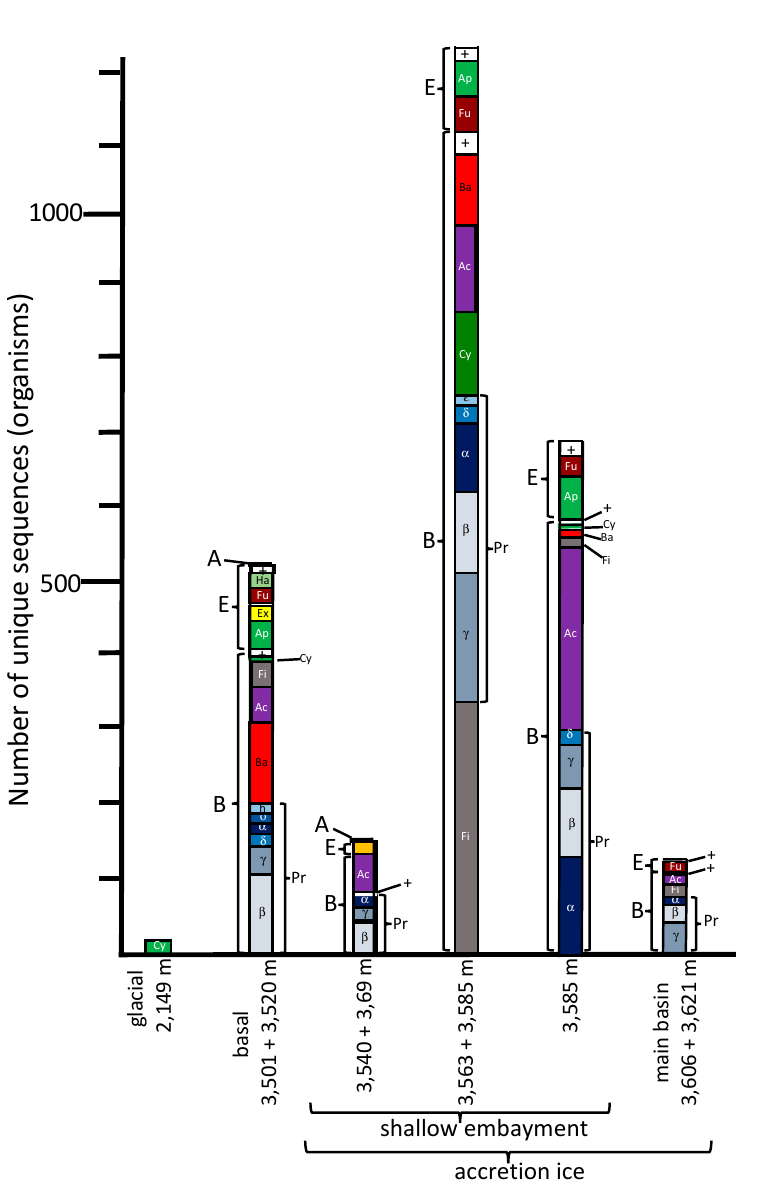
Figure 2. Comparisons of the total numbers and taxonomic affinities of sequences from each of the ice core samples. Abbreviations: Domains—A = Archaea; B = Bacteria; E = Eukarya. Other taxonomic